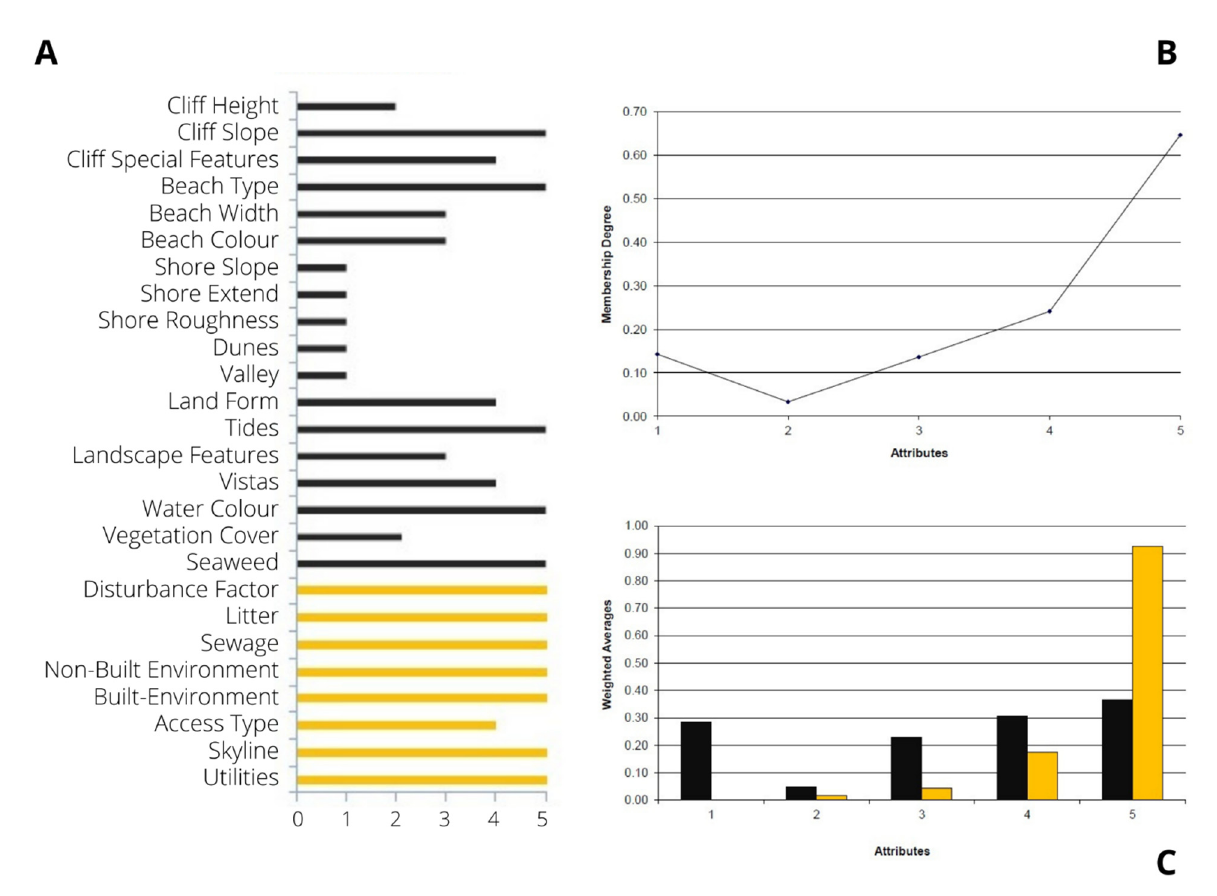
Figure 4. Scenic evaluation rating histograms for Cala Media Luna, Andalusia (Spain, Almería province; D: 1.01; Class I) ( A ), membership degree vs. attributes ( B ) and weighted averages vs. attributes ( C ).